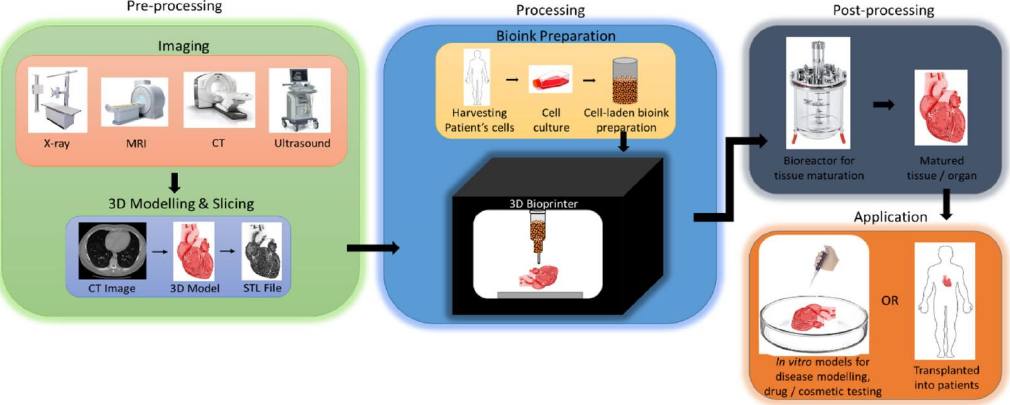
Figure 2. Schematic illustration for the process of 3D bioprinting. Reprinted with permission from ref. [20].